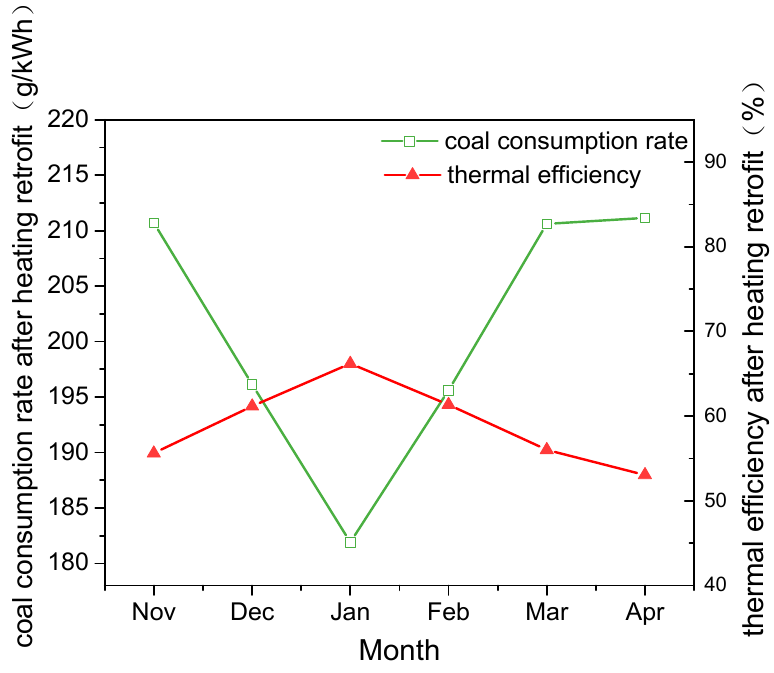
Figure 7. Coal consumption rates and thermal efficiencies at the maximum heating capacity.